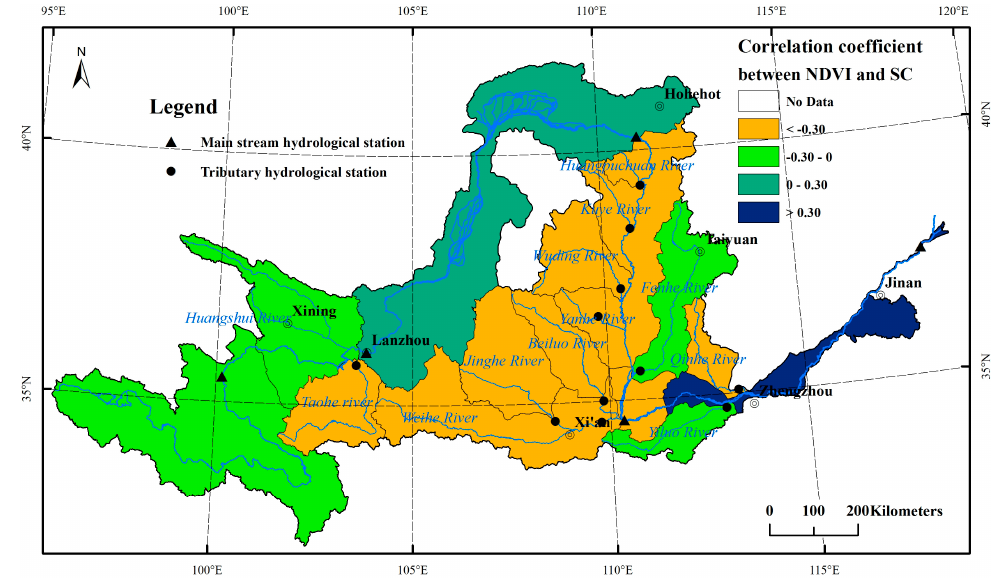
Figure 11. Correlation coefficients between NDVI and the sediment concentration in the Yellow River basin.